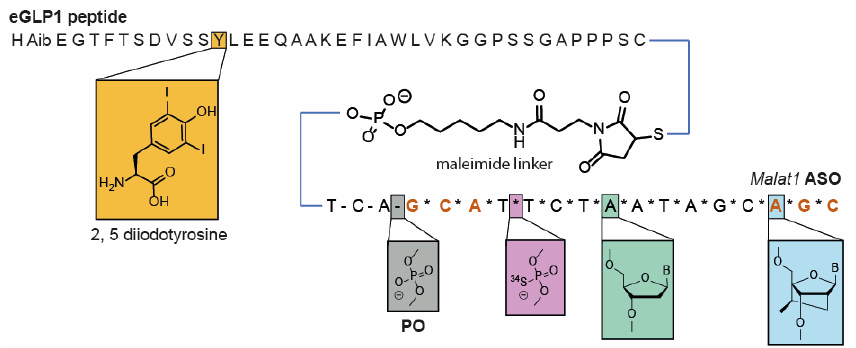
Figure 2. Schematic of double-labelled GLP1-ASO conjugate with maleimide linker. We sought to verify that this dual labeling did not impede the eGLP1-ASO function. Both 127 I 2 -eGLP1- 34 S 15 -ASO and the unlabeled eGLP1-ASO had similar activity in the PathHunter ® GLP1R-Activated GPCR Internalization U2OS Cell Line (Figure 3a). We observed reduced maximal activity but a similar potency for activating GLP1R internalization for both conjugates compared to eGLP1 (Figure 3a), in line with our previous work [10]. These eGLP1-ASO conjugates also demonstrated a comparable efficacy for reducing Malat1 expression in GLP1R-HEK293 cells (Figure 3b). Overall, the incorporation of 127 I 2 and 34 S 15 labels did not appear to impede the eGLP1-ASO activation of GLP1R or Malat1 RNA knockdown, and this conjugate was suitable for studying eGLP1-ASO subcellular trafficking.